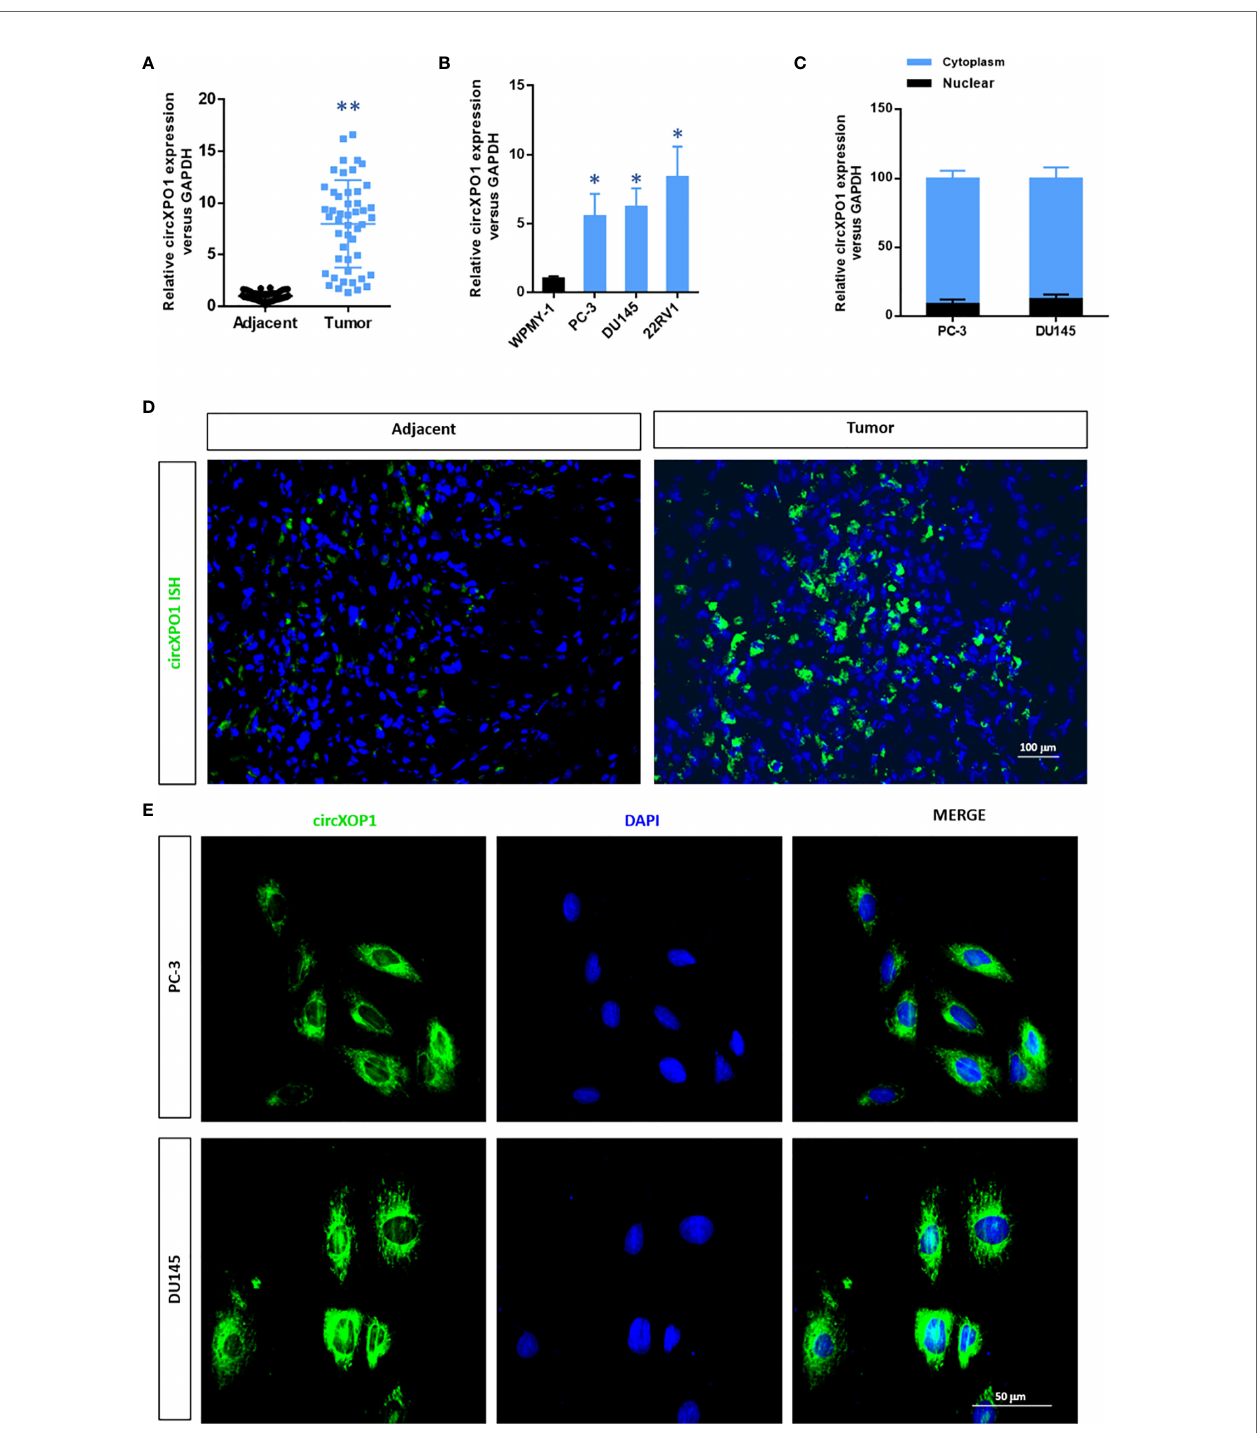
FIGURE 1 | CircXPO1 expression was upregulated in prostate cancer tissue and cell lines. (A) Quantitative real-time PCR (qRT-PCR) was performed to determine circXPO-1 expression in pancreatic cancer tissue and adjacent normal tissue. Data are expressed as the means ± standard deviation (SD). ** P < 0.01 vs. adjacent normal tissue; n = 48. (B) qRT-PCR was performed to determine circXPO-1 expression in normal prostatic stromal myo fi broblast cell line WPMY-1 and pancreatic cancer cell lines (PC-3, DU145, 22RV1). Data are expressed as the means ± SD. * P < 0.05 vs. WPMY-1; n = 3. (C – E) qRT-PCR (C) and fl uorescence in situ hybridization assay (D, E) were conducted to examine the nuclear and cytoplasmic expression of